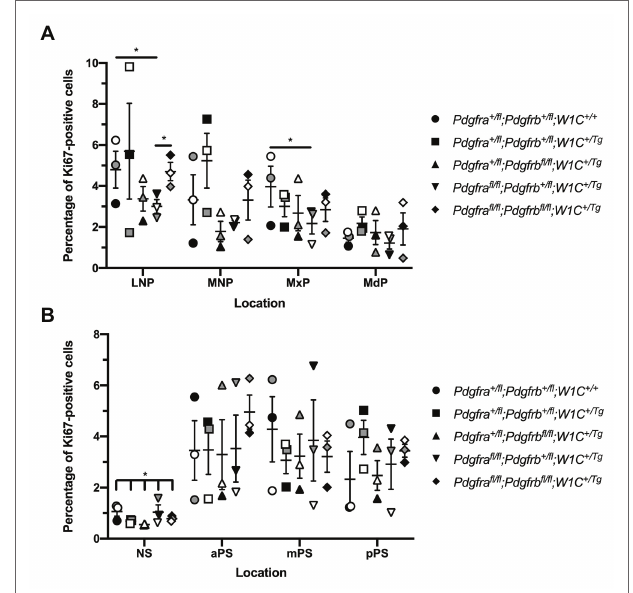
FIGURE 8 | PDGFR α plays a more dominant role in proliferation of the craniofacial mesenchyme at E10.5, while PDGFR β has a more pronounced effect at E13.5. (A) Scatter dot plot depicting the average percentage of Ki67- positive cells per embryo in the nasal processes and facial prominences across five genotypes at E10.5. Data are presented as mean ± SEM. * p < 0.05. Shades correspond to independent experiments across three biological replicates. LNP, lateral nasal process; MNP, medial nasal process; MxP, maxillary prominence; and MdP, mandibular prominence. (B) Scatter dot plot depicting the average percentage of Ki67-positive cells per embryo in the NS and secondary palatal shelves across five genotypes at E13.5. Data are presented as mean ± SEM. * p < 0.05. Shades correspond to independent experiments across three biological replicates. NS, nasal septum; aPS, anterior secondary palatal shelves; mPS, middle secondary palatal shelves; and pPS, posterior secondary palatal